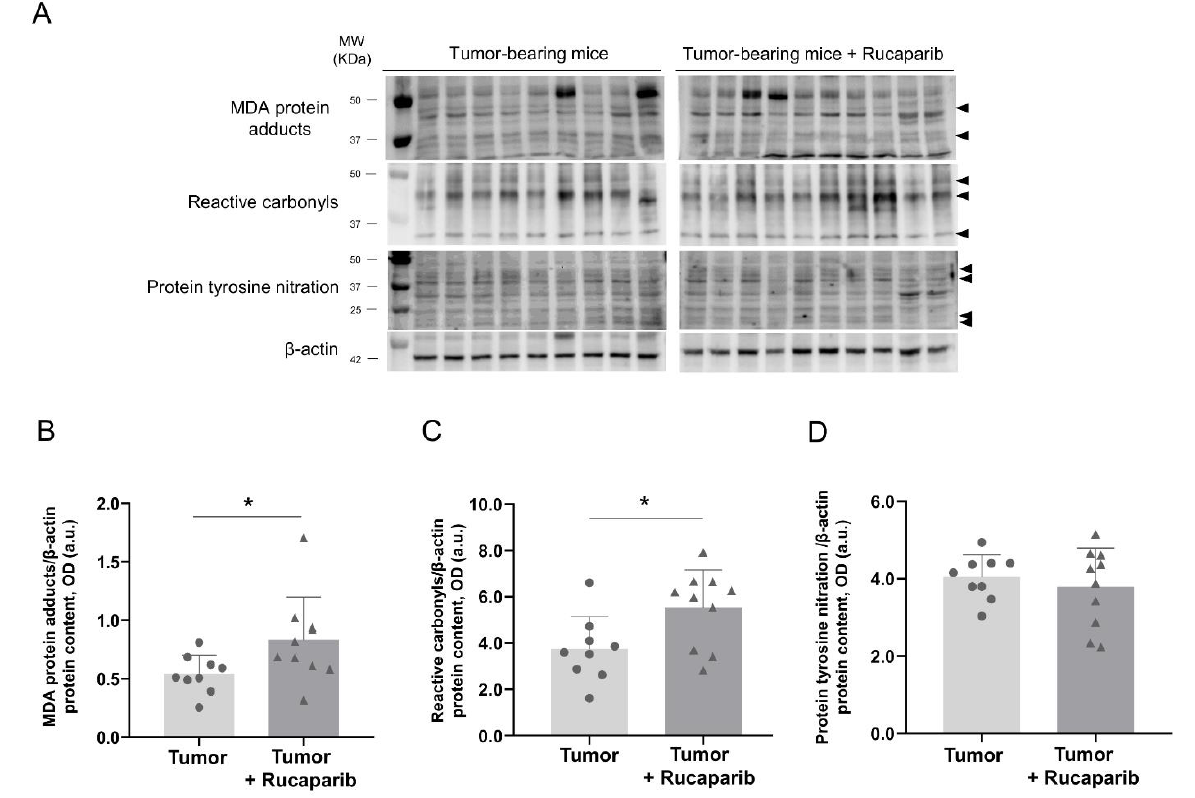
Figure 6. Representative immunoblots of MDA-protein adducts, protein tyrosine nitration, reactive carbonyls and β -actin proteins in the tumors of both study groups ( A ). Mean values and standard deviations of MDA protein adducts ( B ), protein tyrosine nitration ( C ) and reactive carbonyls ( D ) protein content. In the scatter plot, the circles represent the untreated tumor-bearing mice while the triangles represent the rucaparib treated tumor-bearing mice. Statistical significance: * p ≤ 0.05 between tumor-bearing mice treated with rucaparib and non-treated tumor-bearing mice. Definition of abbreviations: MDA, malondialdehyde; OD, optical densities; a.u., arbitrary units.